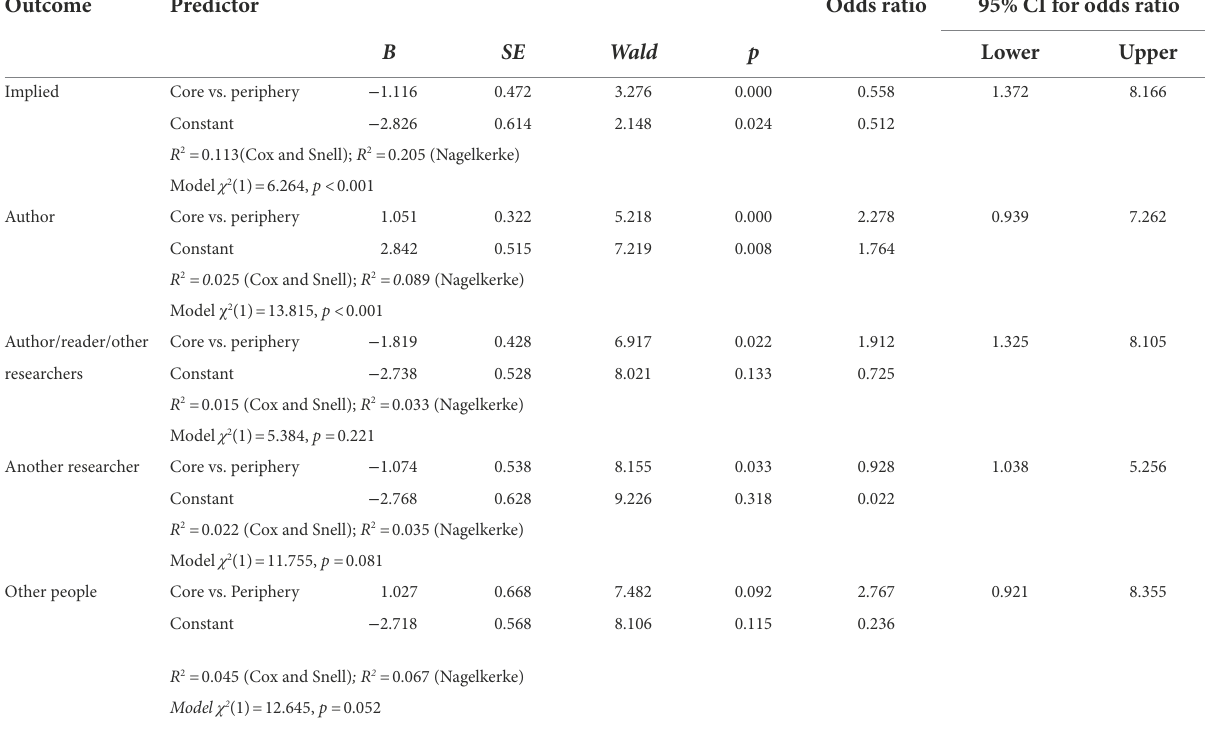
TABLE 7 Results of binary logistic regressions on the frame element of experiencer.